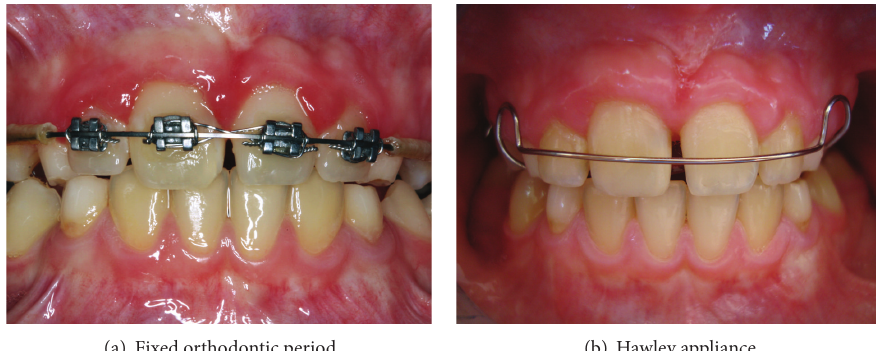
Figure 4: Orthodontic therapy.